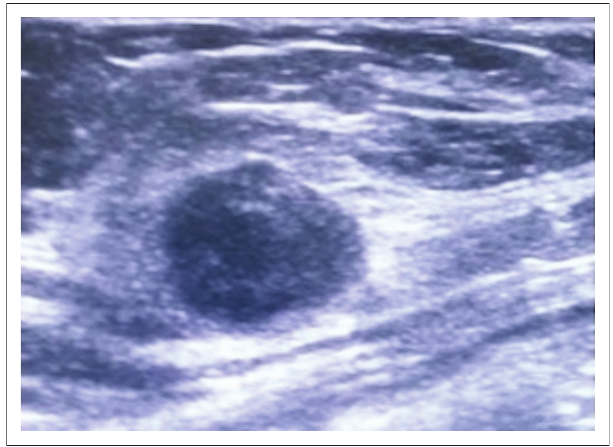
FIGURE 3: Left breast lump in a 44-year-old woman 3 years prior to presentation. Ultrasound examination showed a round hypoechoic mass with circumscribed margins and posterior acoustic enhancement. Ultrasound assessment was Breast Imaging Reporting and Data Systems 3 (probably benign). Histologic diagnosis was invasive ductal